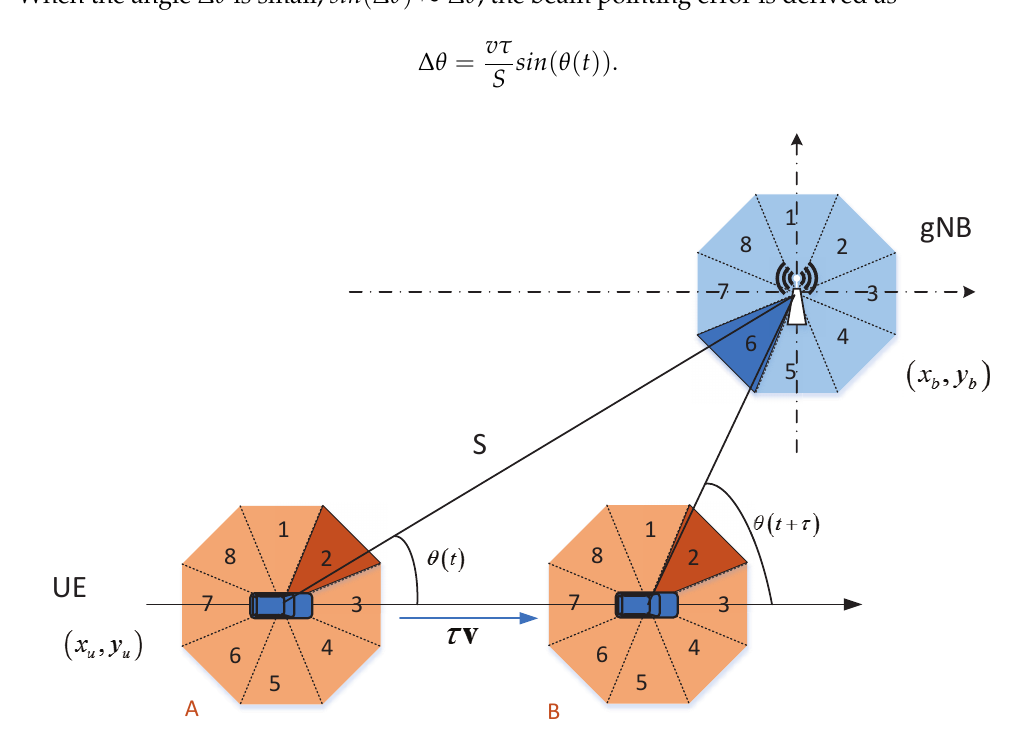
Figure 3. Motion model in two dimensional